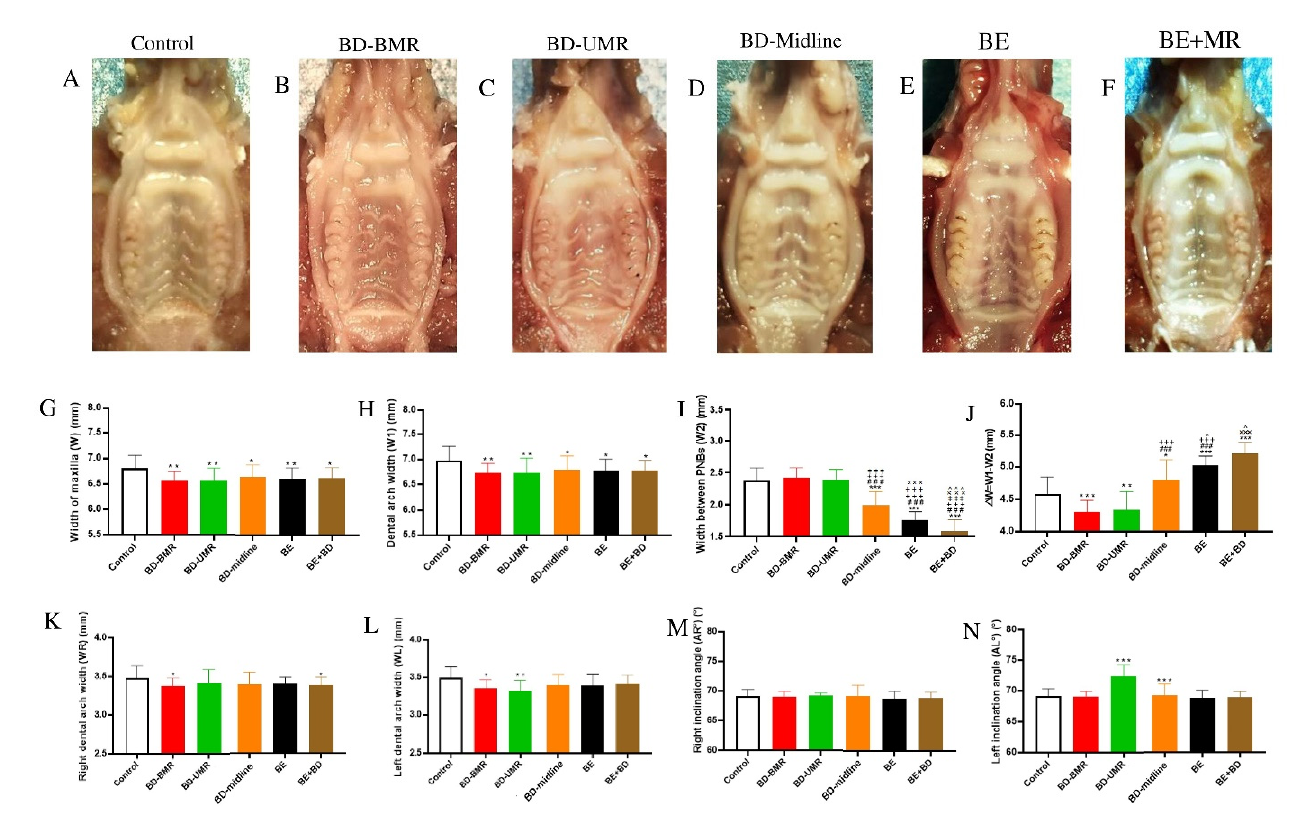
Figure 3. ( A – F ) The palatal rugae and scar on the palates at nine weeks after various degrees of palatal trauma. ( G – N ) Parameters demonstrated the inhibitions of the maxillofacial growth after bone denudation and destruction. One-way ANOVA was used to evaluate the statistical significance (* p < 0.05, ** p < 0.01, and *** p < 0.001). *, compared with the control group; #: compared with the BD-BMR group; +: compared with the BD-UMR group; × compared with the BD-midline group; ˄: compared with BE-group.